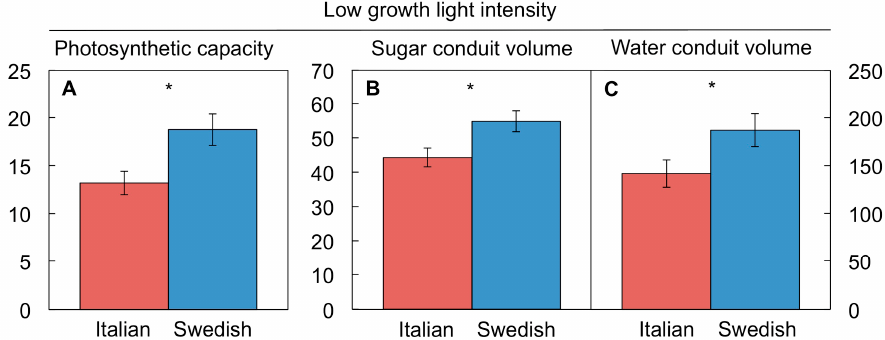
Figure 6. ( A ) Photosynthetic capacity (µmol O 2 m − 2 ·s − 1 ) and volumes (mm 3 m − 2 ) of minor-vein ( B ) sugar-transporting and ( C ) water-transporting conduits in leaves of Italian and Swedish ecotypes of A. thaliana grown under low light intensity (100 µmol photons m − 2 ·s − 1 ) at moderate leaf temperature (20 °C). Mean values ± standard deviations ( n = 4); significant differences ( t -test) indicated by asterisks—* = p < 0.05. Data from Stewart et al. [86].